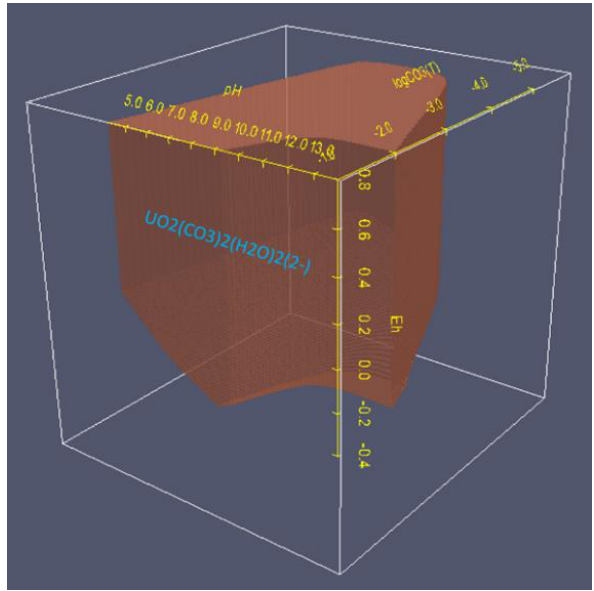
Figure 32. Semi-transparent plot that shows the stability region of UO 2 (CO 3 ) 2 (H 2 O) 22− species.